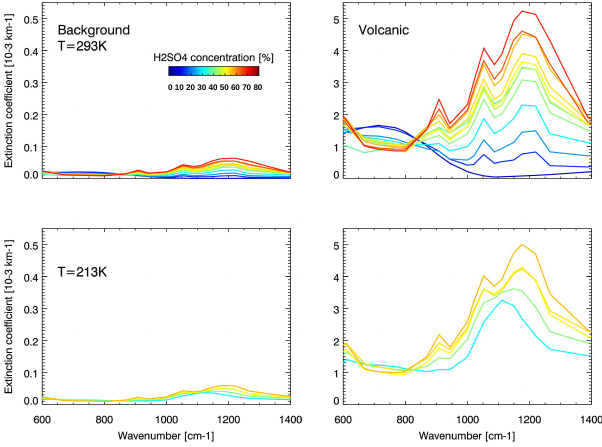
Figure 2. Spectral extinction coefficients for sulfate aerosol lay- ers with different H 2 SO 4 mixing ratios, from 0 to 80% as indi- cated by the colour bar, and temperatures of 293K (upper row) and 213K (bottom row). Different mixing ratio/temperature combina- tions are shown, depending on the availability in the refractive in- dices data set of Biermann et al. (2000). The extinction coefficients are shown for a typical background size distribution (left column) and for a moderate volcanically perturbed size distribution (right column). See the text for further